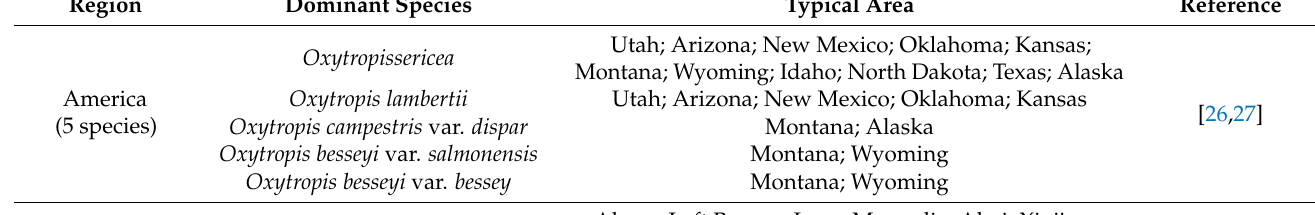
Table 1. Species and distribution of poisonous Oxytropis spp. in the natural grasslands of the Western United States and China.